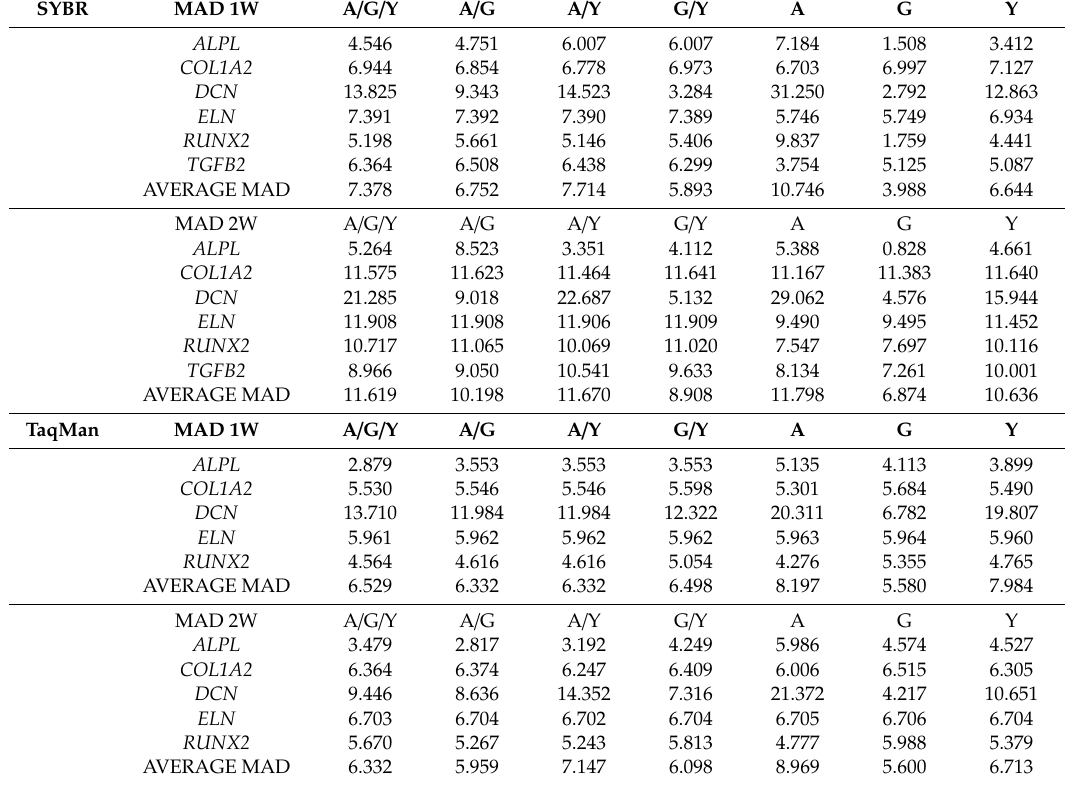
Table 4. Comparative Median Absolute Dispersion (MAD) analysis of reference genes ACTB , GUSB , YWAHZ . SYBR